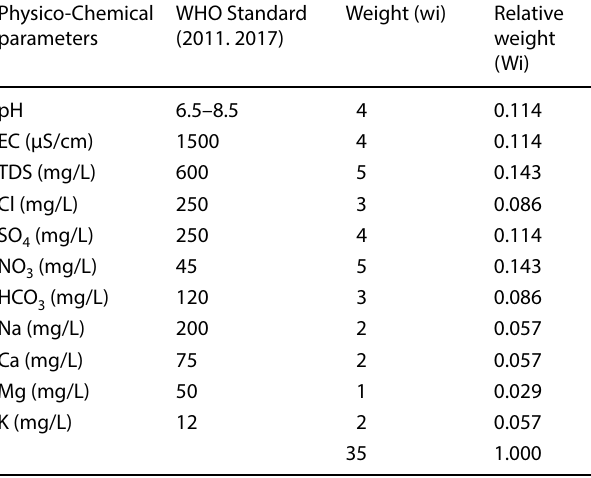
Table 1 Groundwater standards World Health Organization (WHO) Physico-Chemical WHO Standard parameters (2011.